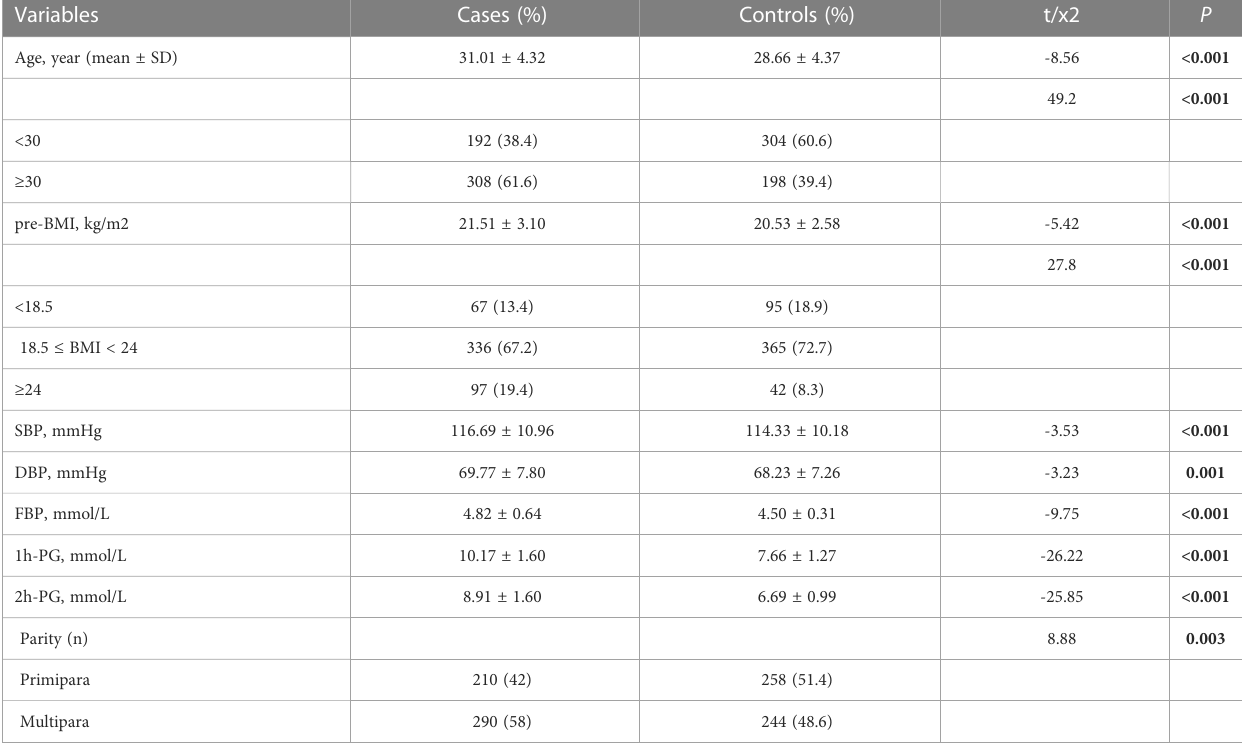
TABLE 1 Basic and strati fi ed characteristic of participants of the study. Variables